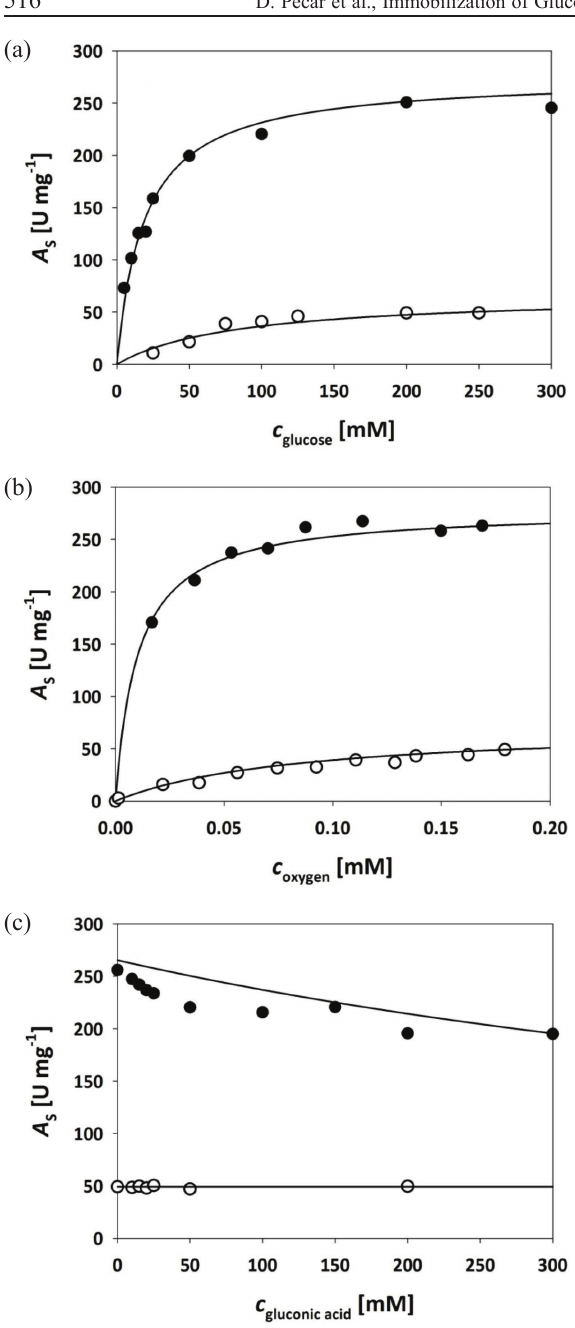
Fig. 2 – Kinetics of free (black circles) and immobilised glucose oxidase (white circles) in the reaction of glucose oxida- tion (0.1 M phosphate buffer pH 7, 30 °C). Impact of initial reaction rate on: a) glucose concentration (c = 0.1816 mM, O 2 γ = 0.26 mg dm –3 , γ = 0.04 mg cm –3 ); b) oxygen free GOD Eu–GOD concentra tion (c = 250 mM, γ = 0.26 mg dm –3 , glucose free GOD γ = 0.02 mg cm –3 ); c) gluconic acid concentration (c = Eu–GOD O 2 0.1816 mM, c = 250 mM, γ = 0.26 mg dm –3 , γ = glucose free GOD Eu–GOD 0.04 mg cm –3 ).